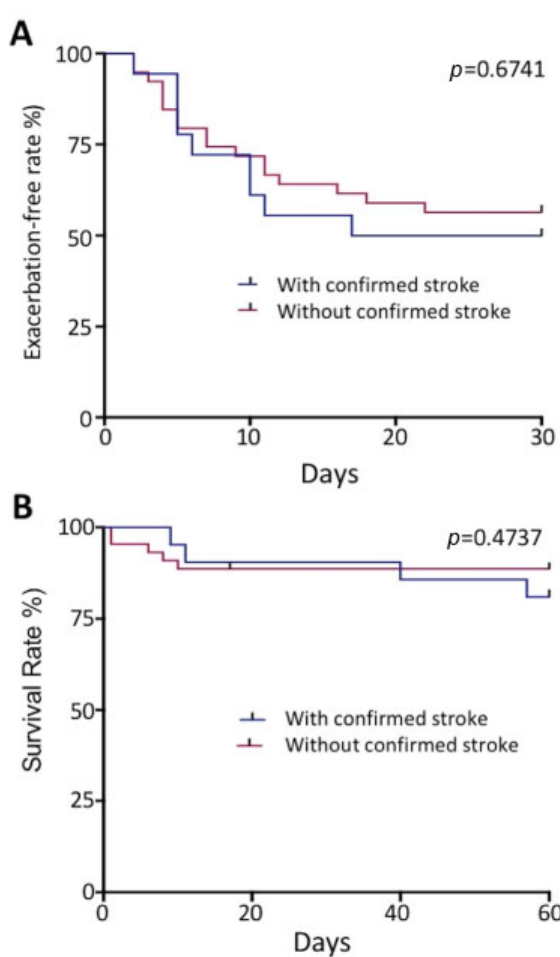
Fig. 2 Kaplan-Meier survival analysis in patients with or without stroke . ( A ) Exacerbationfree rate (%) in patientswith or without stroke 30 days following the cessation of TPE; ( B ) 60-day survival rate in patients with or without stroke since